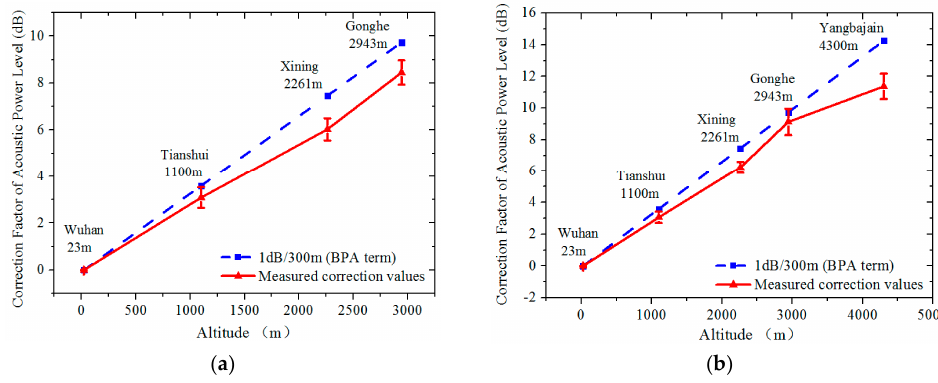
Figure 7. RI correction values of different altitudes. ( a ) Average values during 16–18 kV/cm; ( b ) average values during 15–16 kV/cm.